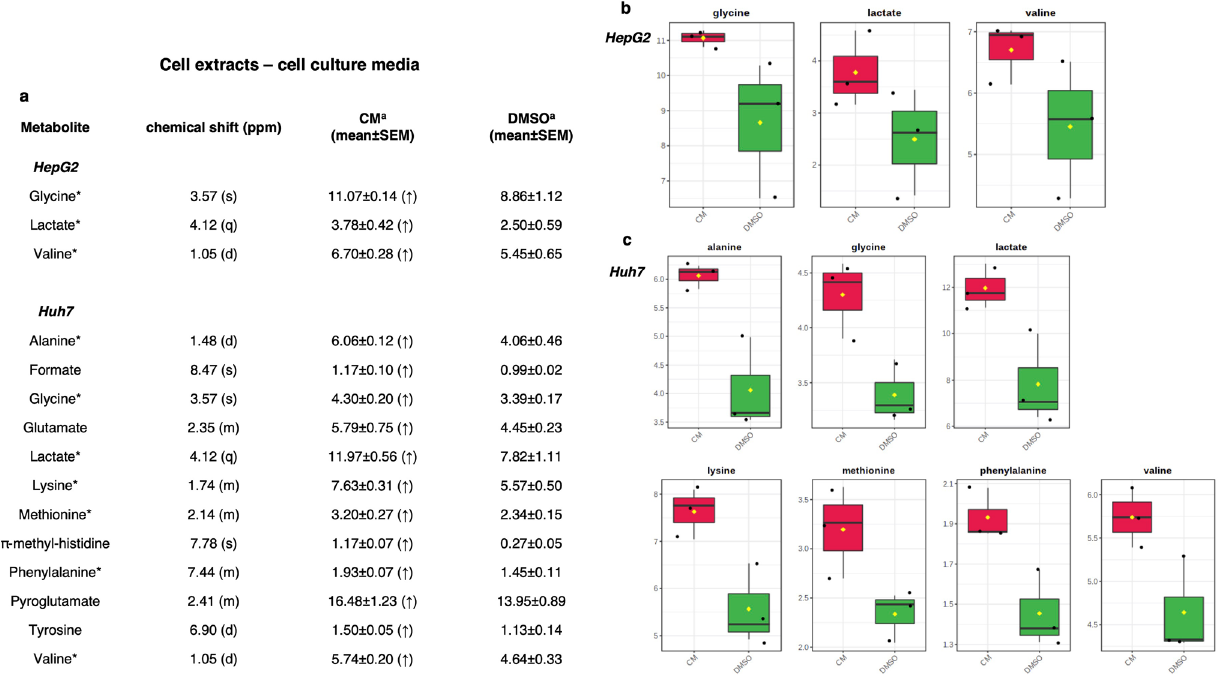
Figure 6. ( a ) Quantitative comparison of metabolites found in cell culture media. Mean and relative standard error mean refers to the relative integrals of metabolites, determined from cell culture media 1D 1 H-NMR spectra of each group (CM and DMSO treatments). Letters in parentheses indicate peak multiplicities (s, singlet; d, doublet, dd, doublet of doublet; q, quartet, m, multiplet). * A p -value threshold of 0.05 was obtained from t-test analysis. ( b , c ) Box-and-Whisker plots illustrating the significant metabolites trend grouped according to CM Crithmum maritimum treatment, DMSO Vehicle treatment, derived from the 1 H-NMR spectra of ( a ) HepG2 and ( b ) Huh7 cell culture